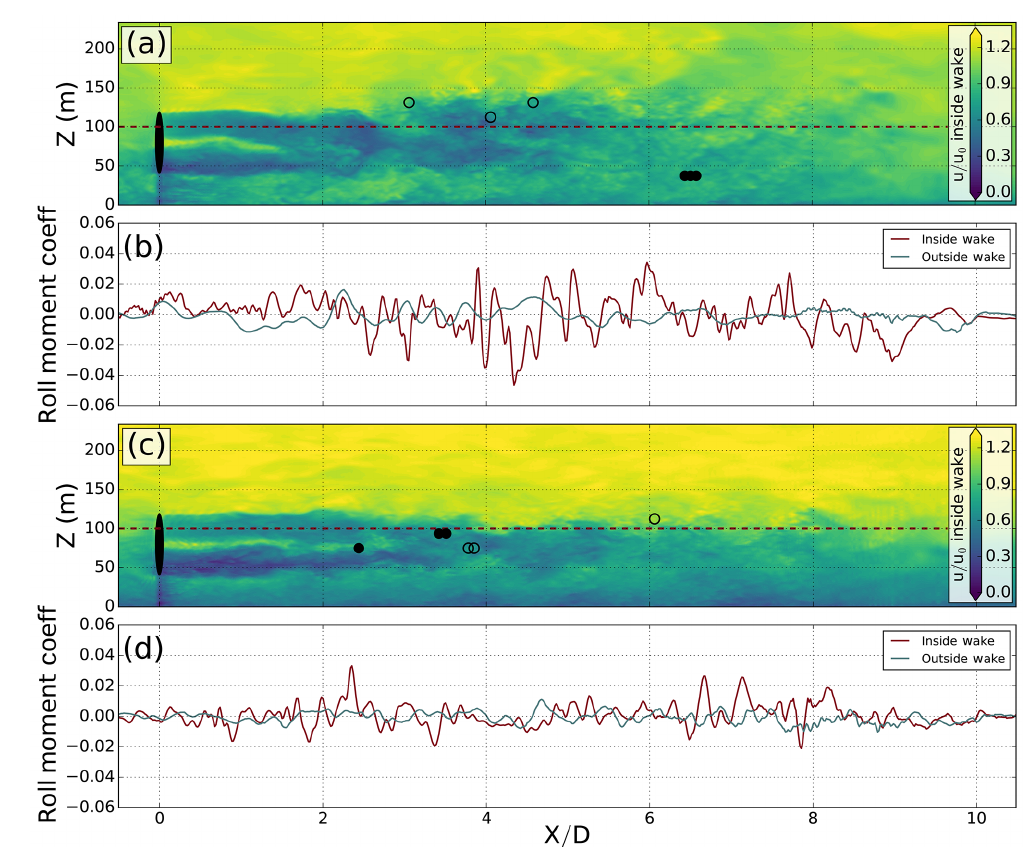
Figure 4. Comparison of rolling moment coefficient (b, d) between the flight path inside (red) and outside (blue) of the turbine wake in the neutral (a, b) and stable (c, d) cases. The vertical cross section of the downwind component of the wind velocity u , scaled by inflow wind speed u 0 , 7.4 and 9.4ms − 1 in neutral and stable conditions, respectively, at the turbine location ( y = 0; a , c ) is contoured for reference, over which the height of the flight paths ( z = 100m) is traced in a red dashed line. The dots represent the downwind and vertical location of the three highest rolling moment coefficients experienced by the down-wake (black) and cross-wake (empty) array of